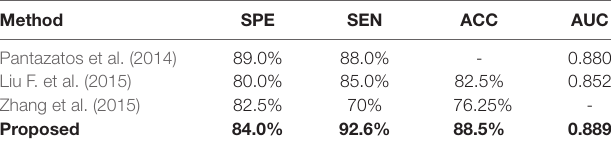
TABLE 4 | Comparison on classification performance of social anxiety disorder (SAD)